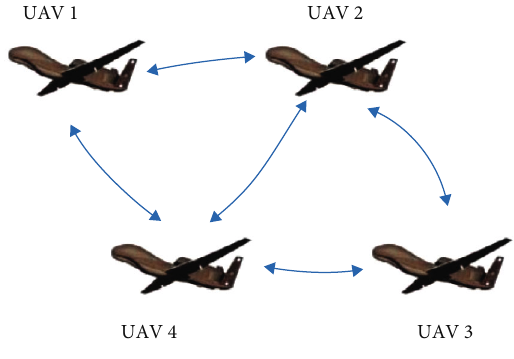
Figure 3: Communication topology. Table 1: Initial attitudes of all